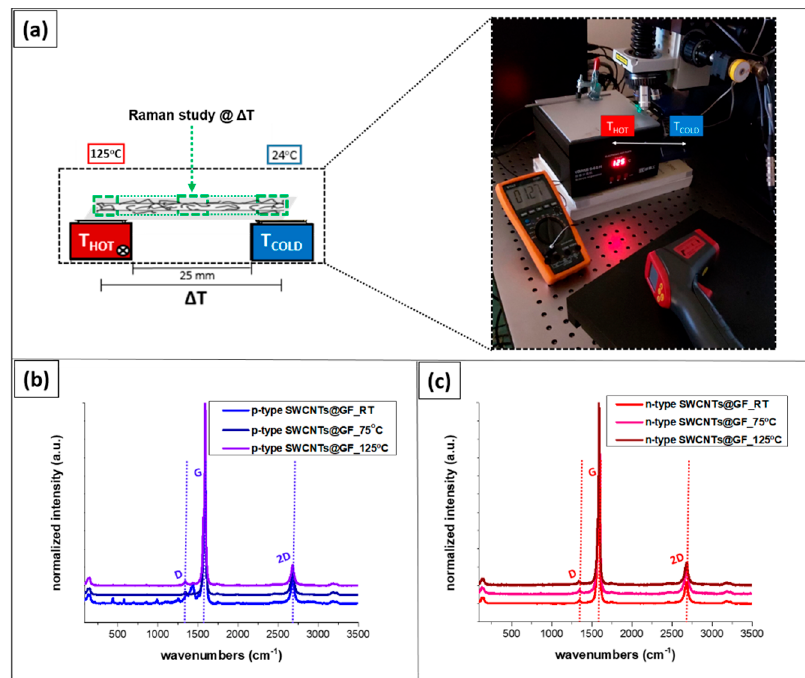
Figure 6. ( a ) Experimental set-up used to study the Raman spectra of p-type SWCNTs coated GFs and n-type SWCNTs coated GFs at room temperature, as well as at ∆ T of 50 ◦ C and 100 ◦ C and ( b , c ) Raman spectra of the p-type and n-type SWCNTs coated GFs at ambient and at temperature gradients of 50 ◦ C and 100 ◦ C,